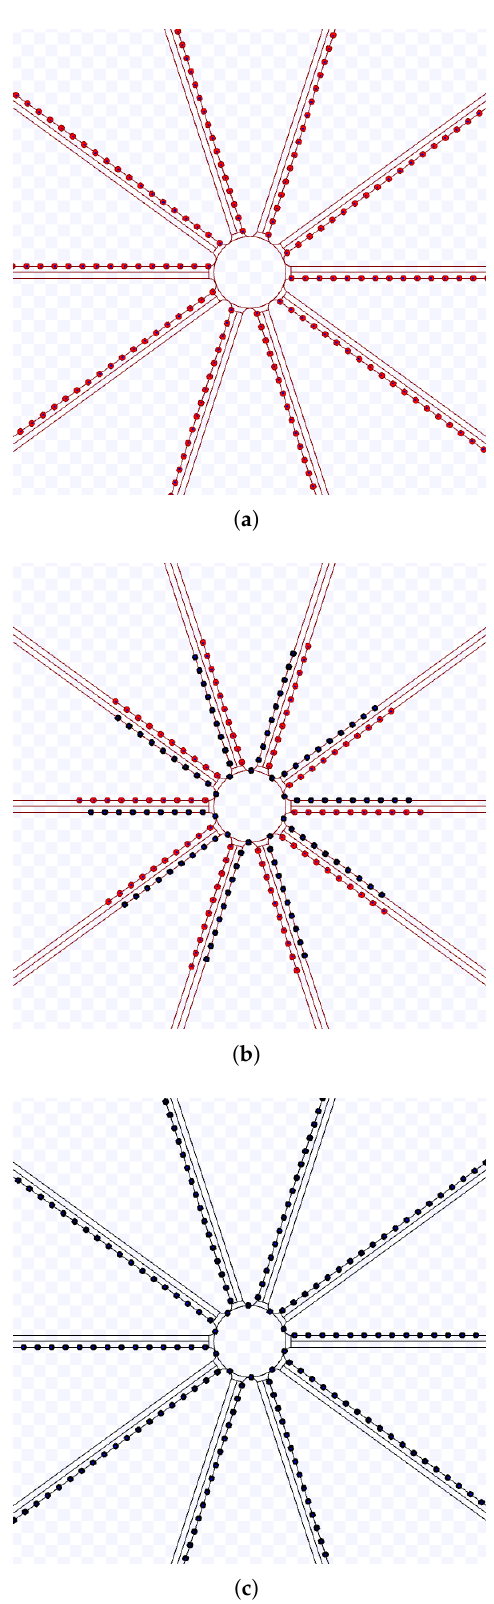
Figure 36. Simulation on Stage for the touch and run strategy using s = 3 m, K = 10 during T = 228 s at v = 0.1 m/s. Available on https://youtu.be/Z-ruOMYFyBU, accessed on 12 June 2022. ( a ) 0 s: beginning of the simulation; ( b ) After 114 s; ( c ) 228 s: ending of the